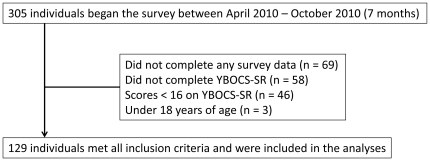
Survey Flow Chart.